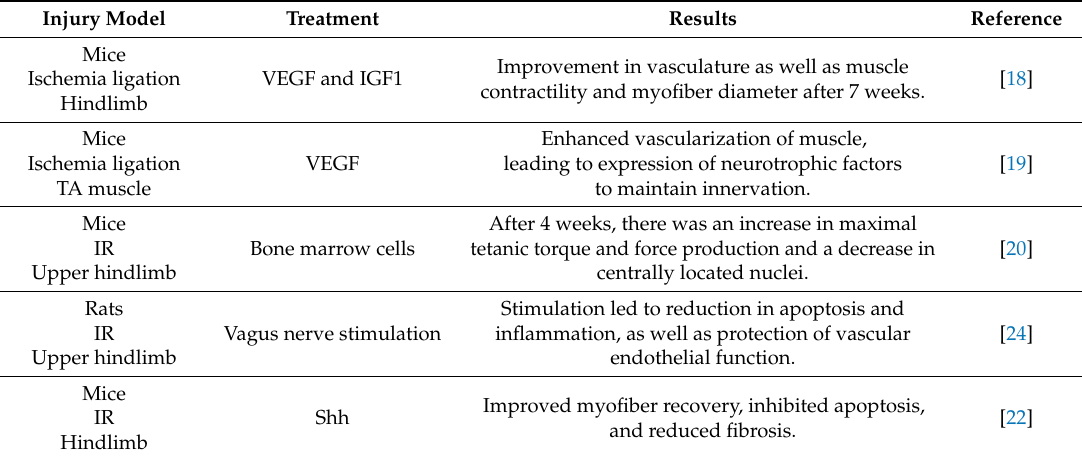
Table 2. Recent studies utilizing ischemia (ligation and ischemia / reperfusion (IR)) to study skeletal muscle regeneration.